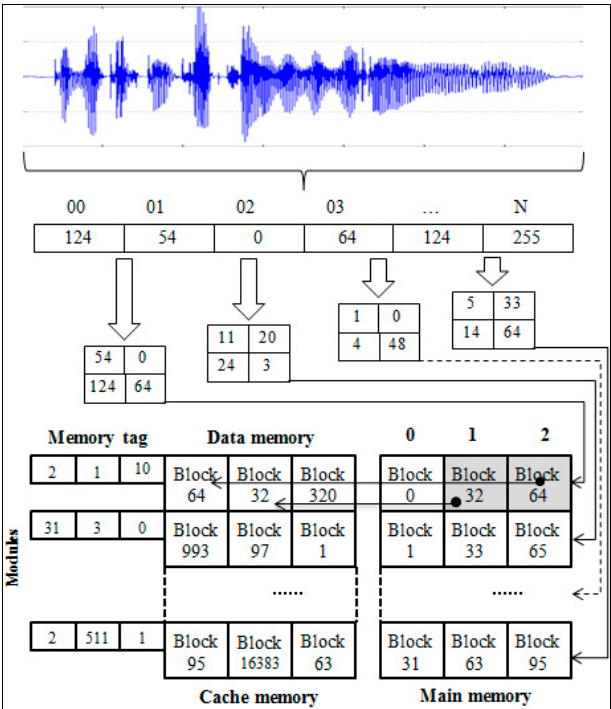
Figure 9. Parallel computing structure using RK3288 processors.